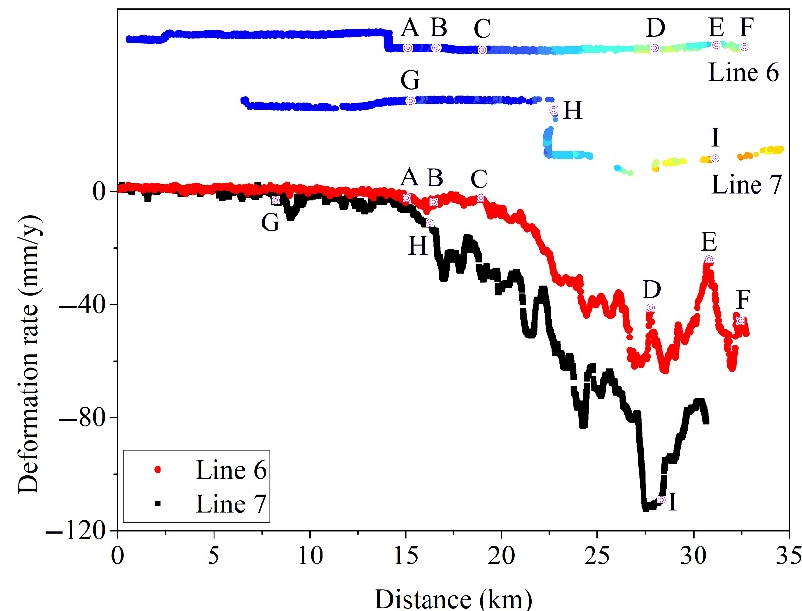
Figure 13. Deformation rate profile of Line 6 and Line 7. The x -axis represents the distance from the west endpoint to the east endpoint. (A) Dongsi Station, (B) Chaoyangmen Station, (C) Hujialou Station, (D) Dalianpo Station, (E) Changying Station, (F) Caofang Station, (G) Ciqikou Station, (H) Huagong Station, (I) Heizhuanghu Station.